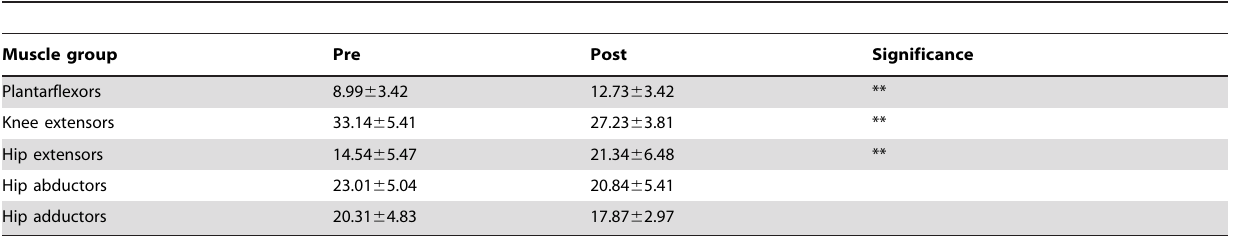
Table 2. Contribution by each of the 5 muscle groups to the summed strength score in the training group (n=15).